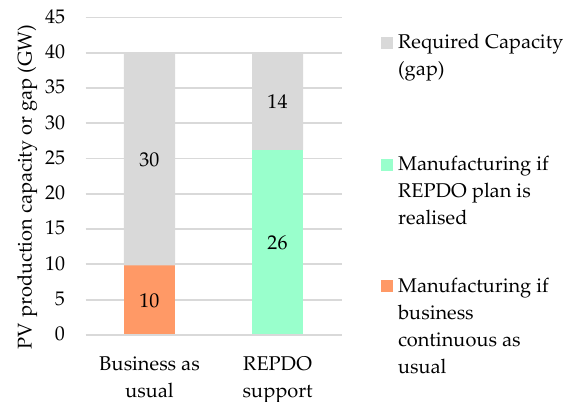
Figure 6. PV module production capacity between 2020 and 2030 in the business-as-usual scenario and REPDO support scenario and the gap between them and the RE plan.